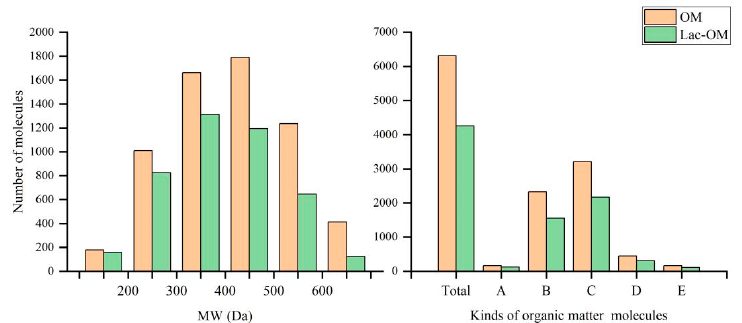
Figure 1. Number of organic matter molecules in different molecular weight intervals and organic matter types (A, polycyclic aromatic hydrocarbons; B, aliphatics; C, lignin, phenolic, highly unsatu- rated; D, polyphenols; E,